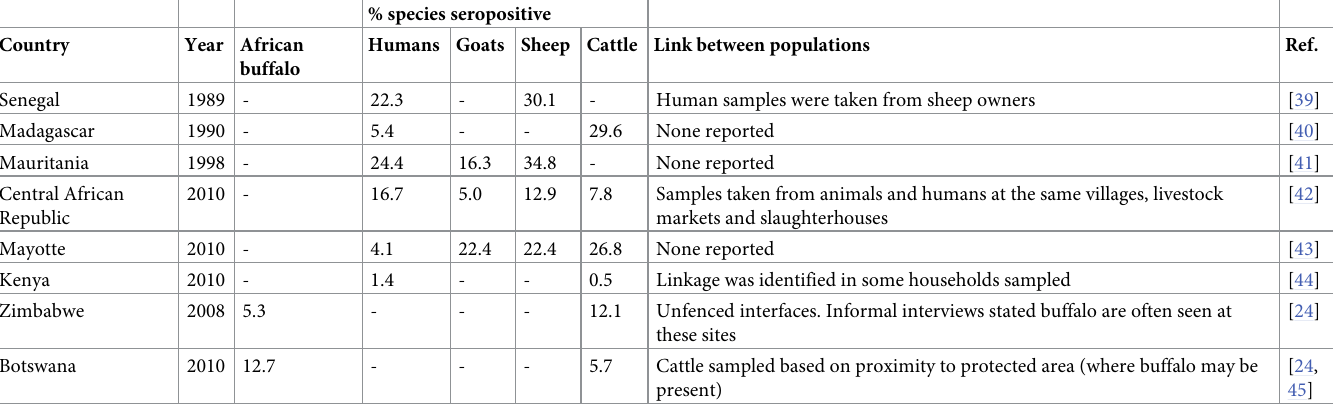
Table 1. RVFV seroprevalence studies conducted in livestock, humans or wildlife concurrently.